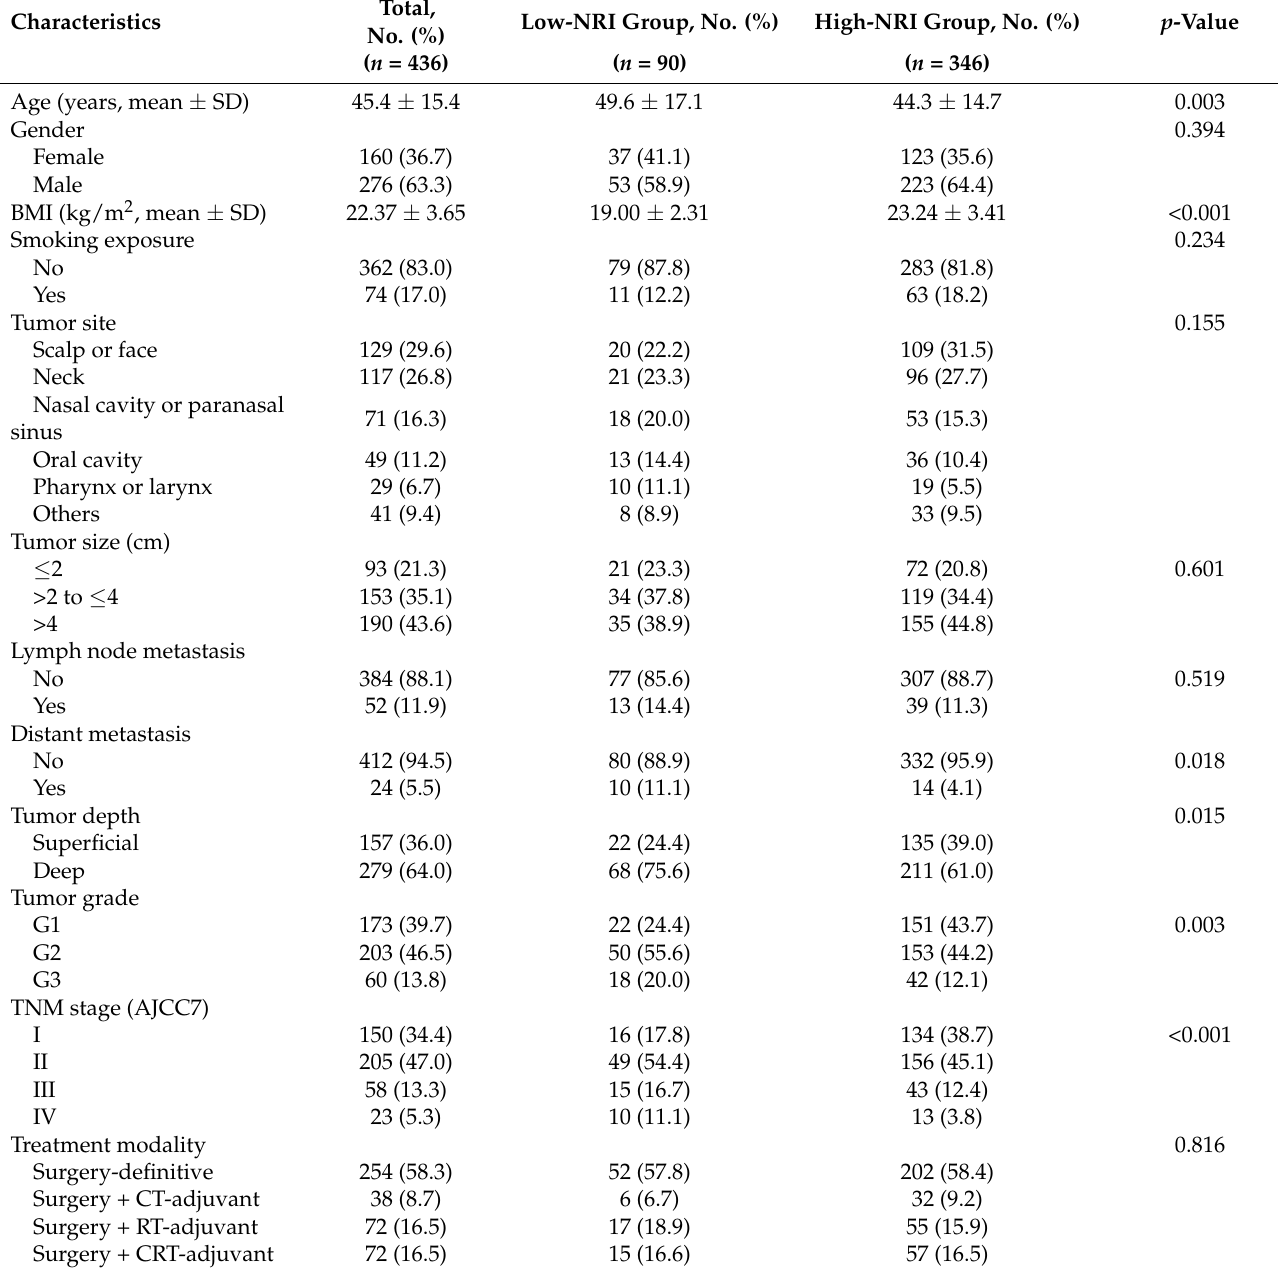
Table 1. Characteristics of patients classified according to